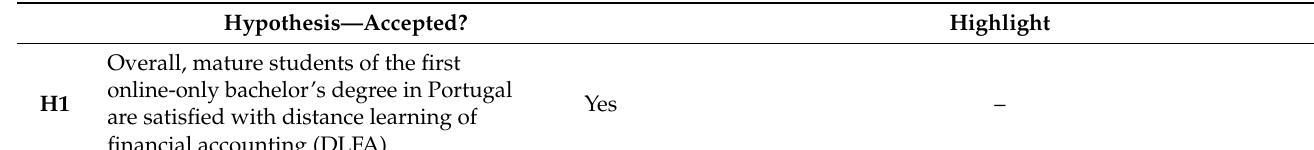
Table 23. Research findings